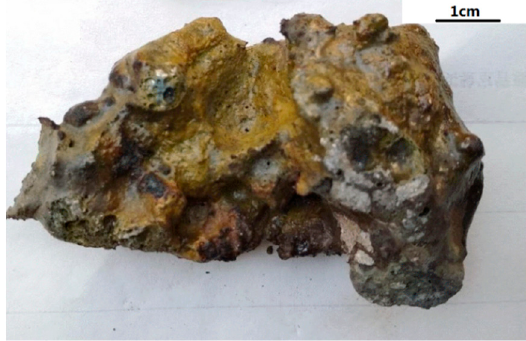
Figure 2. Morphology of floater steel collected from mold. Metals 2019 , 9 , x FOR PEER REVIEW